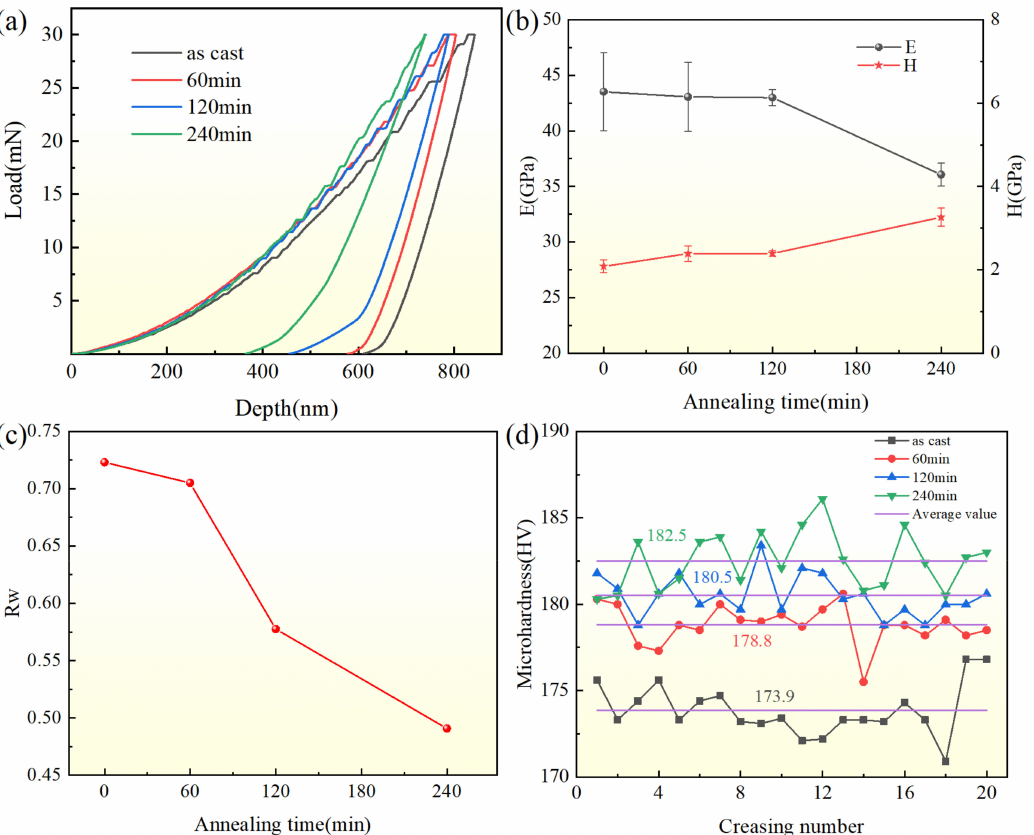
Figure 4. ( a ) Load-depth curves of La 65 Al 14 Ni 5 Co 5 Cu 9.2 Ag 1.8 BMG annealed at 393 K for different time; ( b ) Variations of elastic modulus (E) and hardness (H) on annealing time; ( c ) Dependence of plasticity criterion (R w ) on annealing time; ( d ) Microhardness of La 65 Al 14 Ni 5 Co 5 Cu 9.2 Ag 1.8 BMG annealed at 393 K for different